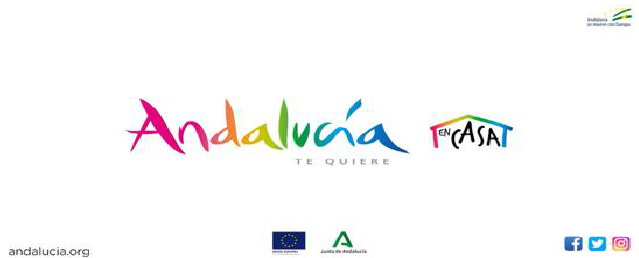
Figure 2. Capture of the campaign “Andalusia Wants You at Home”. Figure 2. C apture of the campaign “Andalusia Wants You at H ome”. Table 2. Analysis of the campaign “ Andalusia Wants You at Home ” .